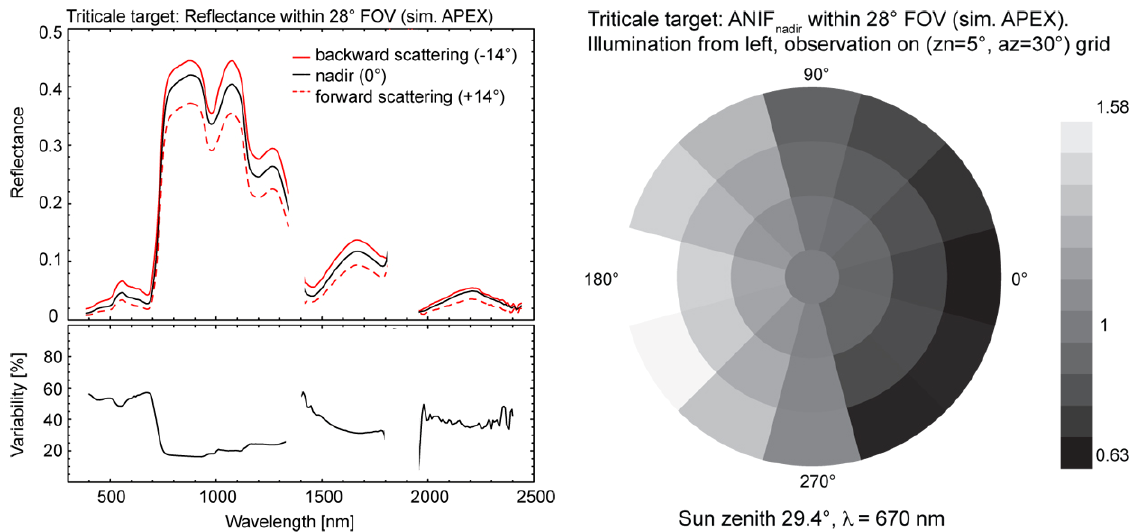
Figure 11. Simulated spectrodirectional signatures (left) and corresponding ANIF (right) for Triticale within the APEX FOV for an observation zenith (zn) angle of 5° and an observation azimuth (az) angle of